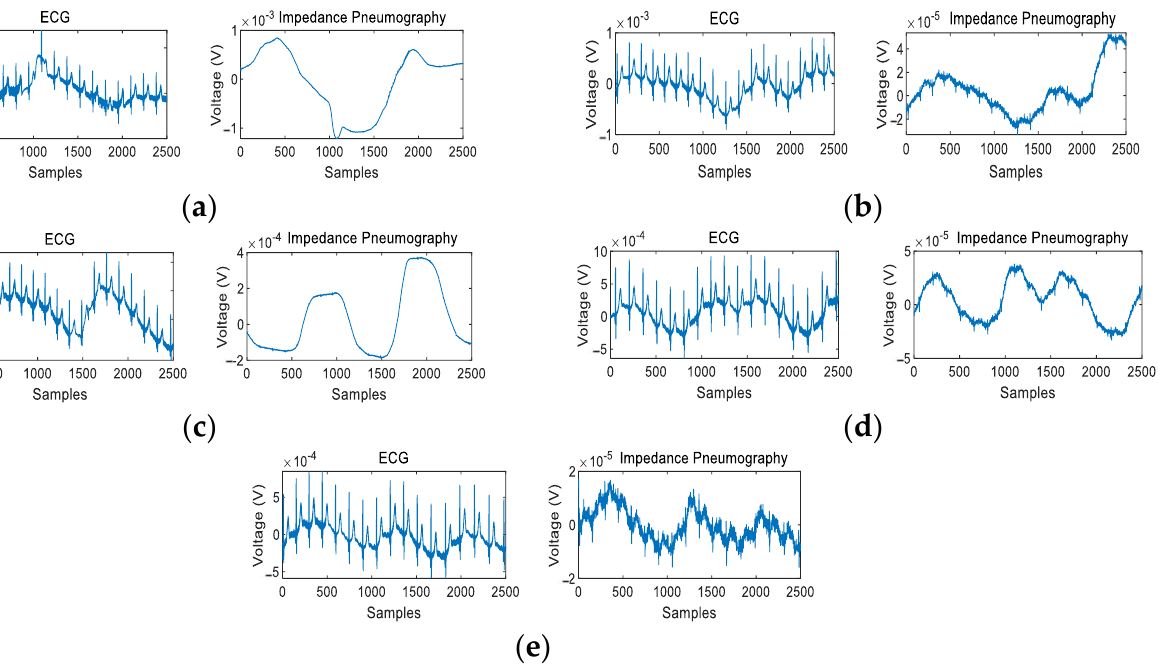
Figure 8. The typical ECG and IP signals recorded under different body motions: ( a ) motion type I, ( b ) motion type II, ( c ) motion type III, ( d ) motion type IV, ( e ) motion type V.